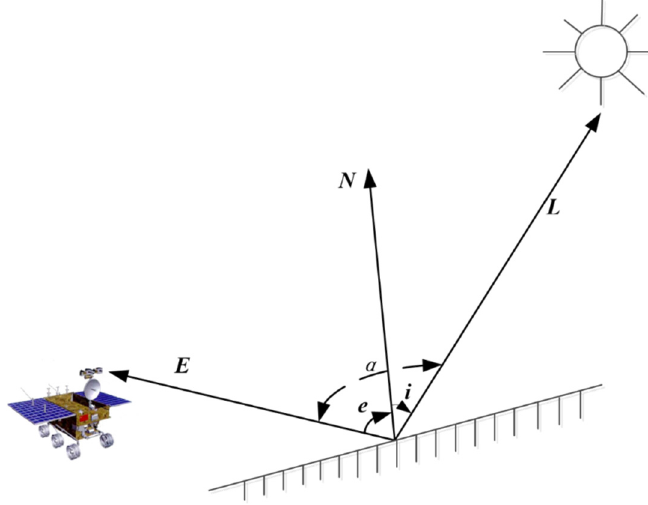
Figure 2. Illustration of rover image formation.